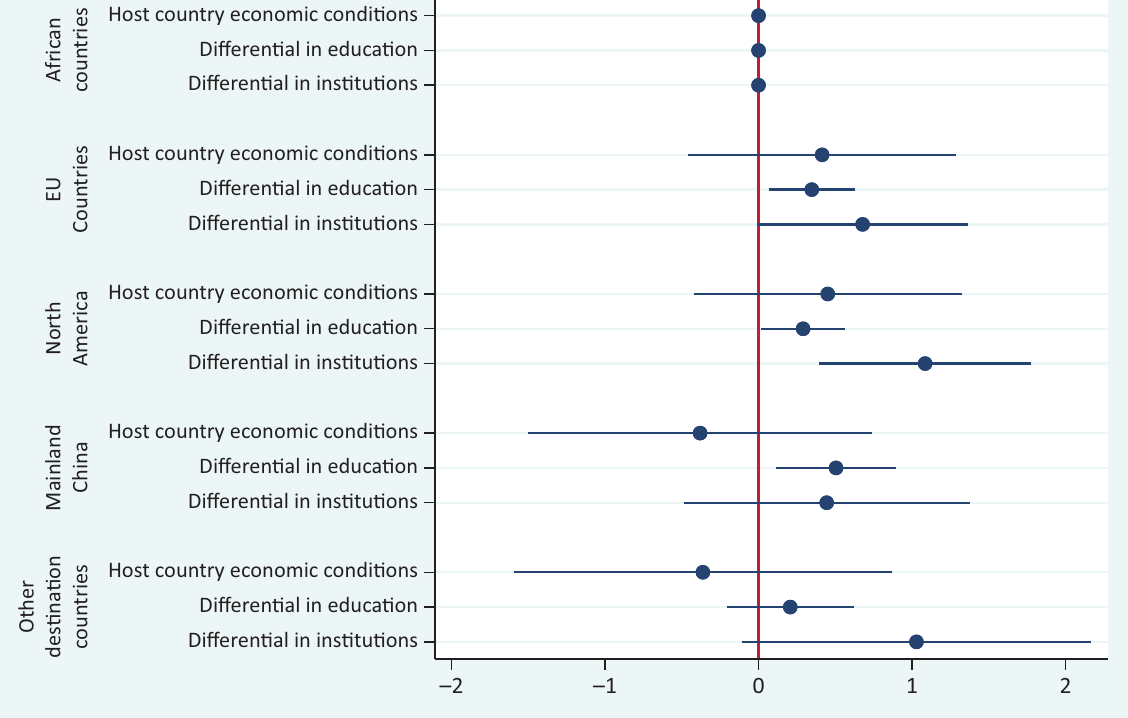
Figure 3. The plot of the multinomial model’s point estimates and 95% confidence intervals. Notes: Figure 3 plots only the coefficients of the explanatory variables of interest regarding the choice of a destination country, including the differen- tial in institutions, the differential in education and the host country’s economic opportunities. The control variables are the index of discrimination, cultural proximity and the characteristics of the respondents such as age, gender, the type of university attended, the student and father’s level of education (see Table 6 of the Supplementary File 1). The dependant variable is polytomous, taking five possible destinations which are the EU, North America, mainland China, African coun- tries and other possible destinations; African countries are treated as the reference destination (base outcomes). The red reference line at zero indicates which point estimate is significantly different from zero. The data used are collected on a sample of 414 Beninese students in